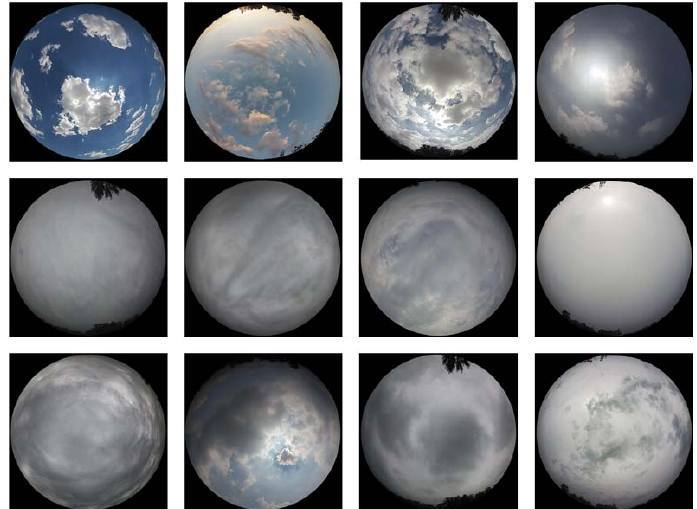
Figure 1. Some examples of ground-based cloud images. Each row indicates the cloud images from the same